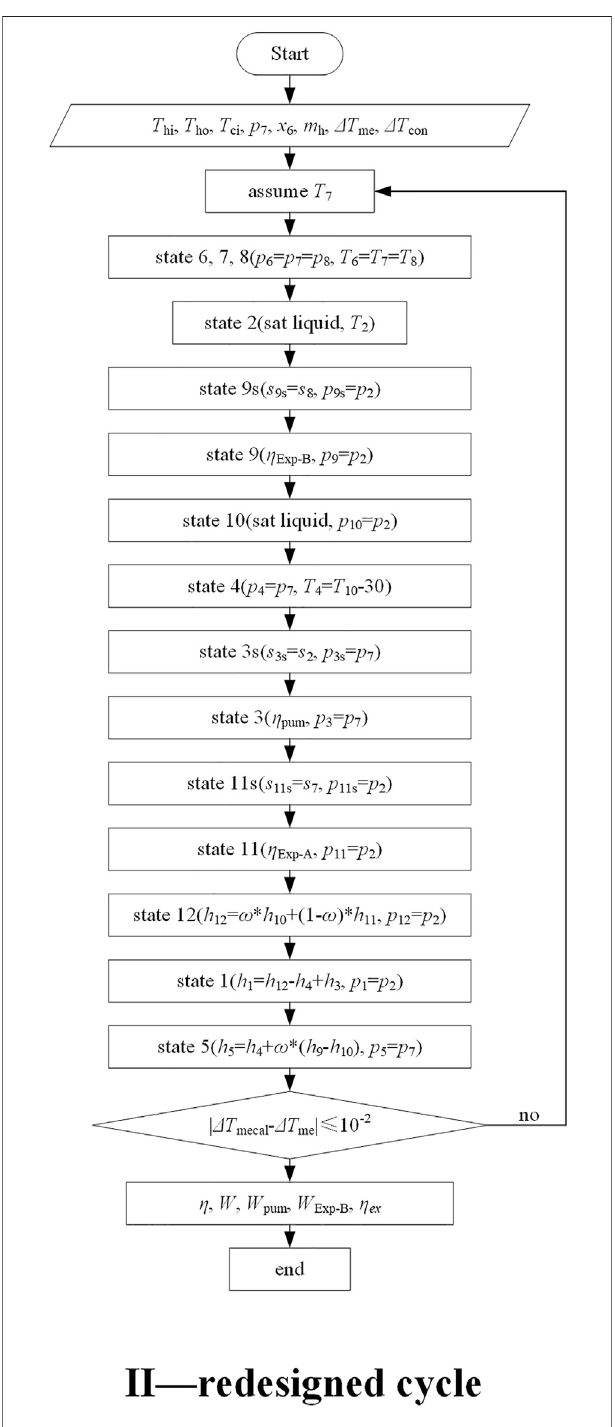
FIGURE 7 | The fl owchart of the calculation program for II-redesigned cycle.